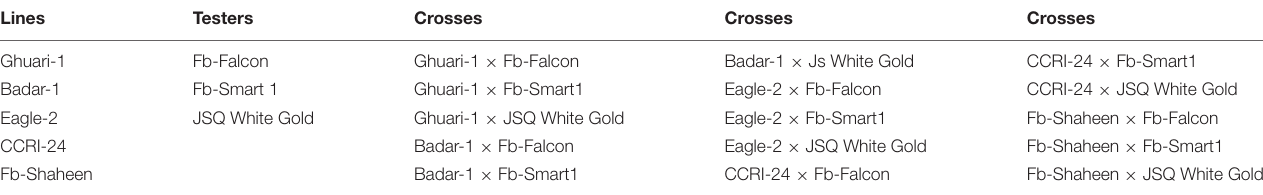
TABLE 1 | List of lines, testers, and their cross combinations used in the experiment. Lines Testers Crosses Crosses